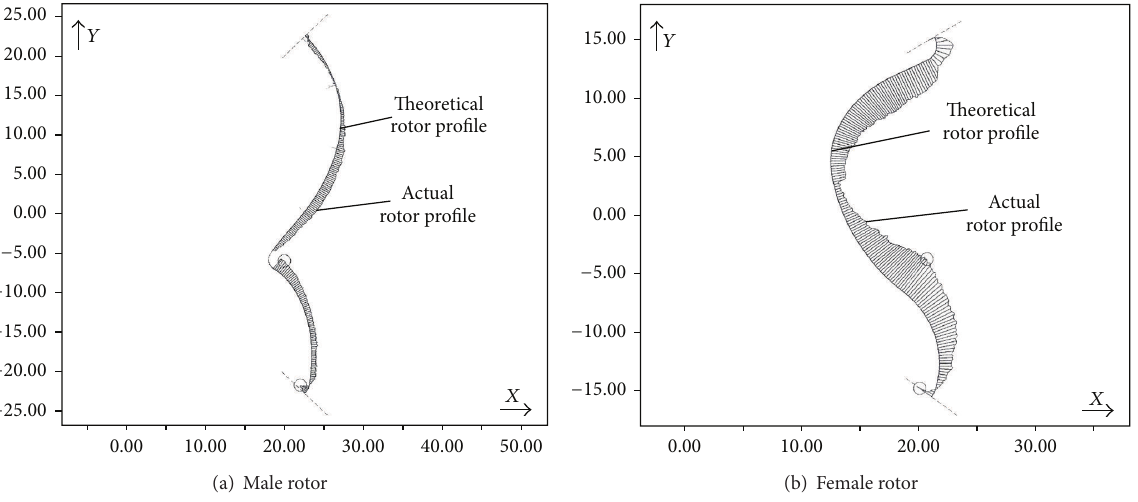
Figure 9: Rotor profile before compensation.